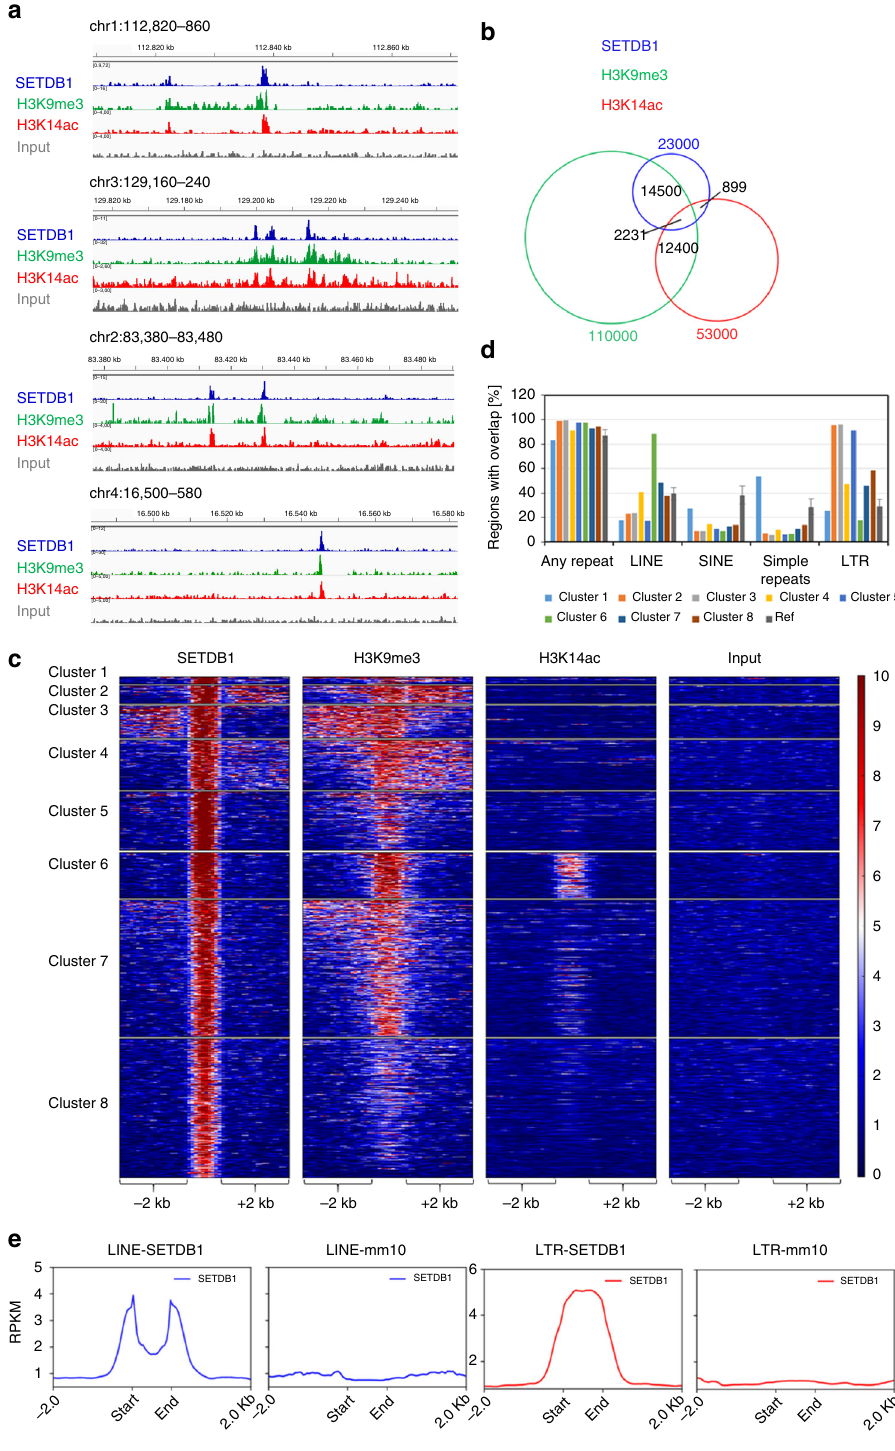
Fig. 6 Genomic binding of SETDB1. a Example browser views of the co-occurrence of SETDB1, H3K9me3, and H3K14ac peaks. b Venn diagram of the overlap of annotated SETDB1, H3K9me3, and H3K14ac peaks. c Clustering analysis of RPKM read density centered on SETDB1 peaks ( ± 2 kb) showing the strong overlap of SETDB1 with H3K9me3 in cluster 1 – 7 and the overlap of SETDB1, H3K9me3, and H3K14ac peaks in cluster 6. d Overlap of the SETDB1 binding regions from cluster 1 – 8 with different classes of repeat elements. “ Ref ” refers to the average of 10 control distributions calculated by EpiExplorer 61 for the different clusters. The standard errors of the average repeat contents in these control distributions are indicated by the error bars. More details and statistics are provided in Supplementary Note 3. Note the strong enrichment of LTRs in clusters 2, 3, and 5 and of LINEs in cluster 6. e Meta-pro fi les of SETDB1 density on SETDB1 overlapping LINE (LINE-SETDB1), all LINE (LINE-mm10), SETDB1 overlapping LTR (LTR-SETDB1), and all LTR elements